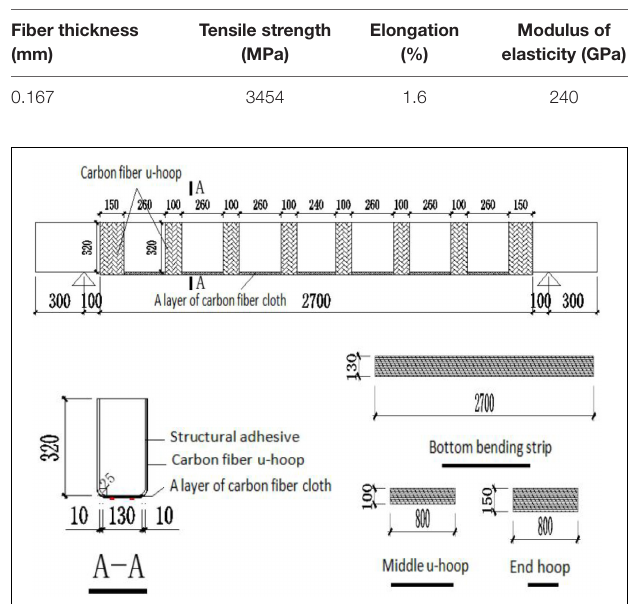
TABLE 4 | CFRP material parameters.